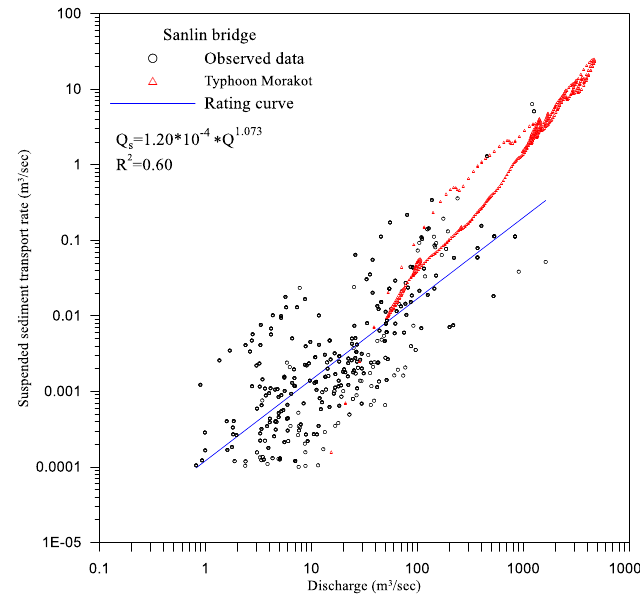
Figure 12. Simulated and observed correlation between flow discharge and sediment transport rate at Sanlin Bridge station.